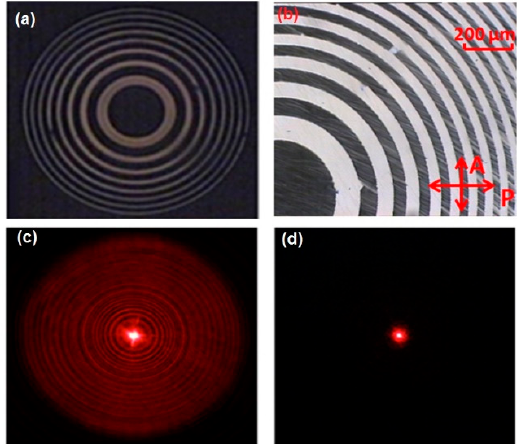
Figure 26. ( a , b ) illustrate the textures of the ESH Fresnel lens under polarized microscope. ( c , d ) show